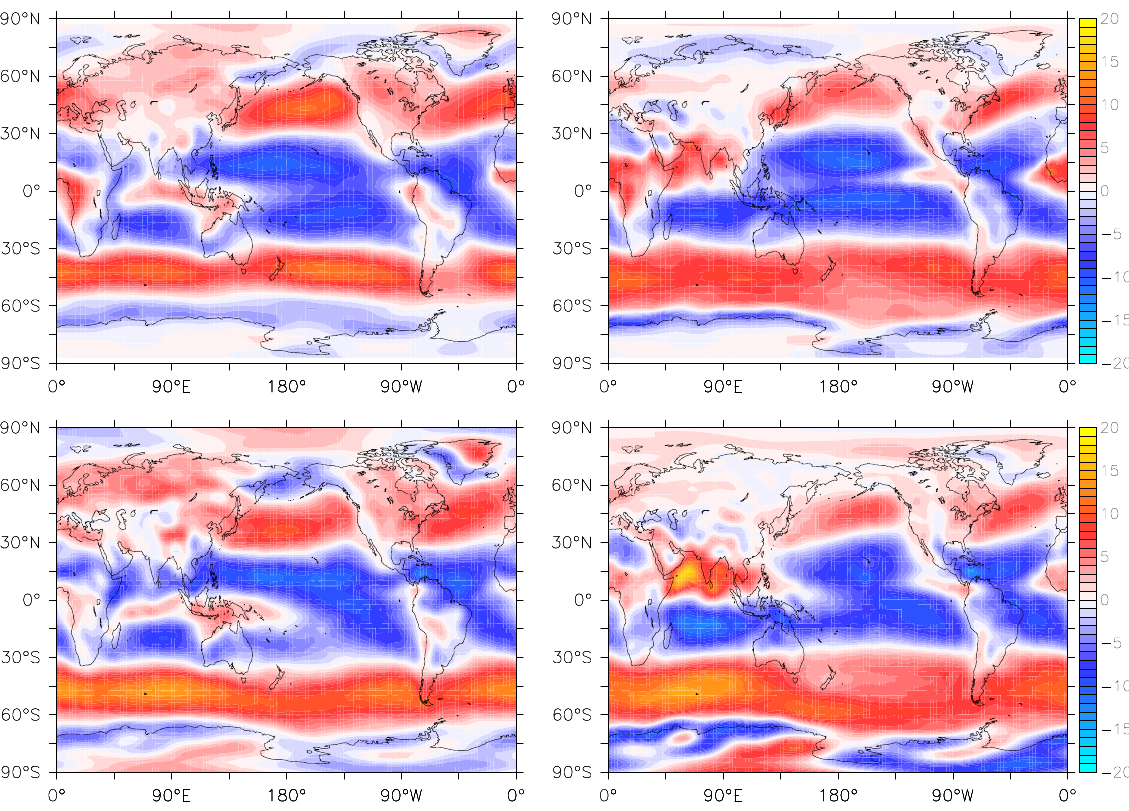
Fig. 4. The zonal wind at 925 hPa in ms − 1 in DJF (left) and JJA (right) of the mean of the SPEEDO ensemble (top) and the reanalysis data from Kalnay et al. (1996), (bottom).